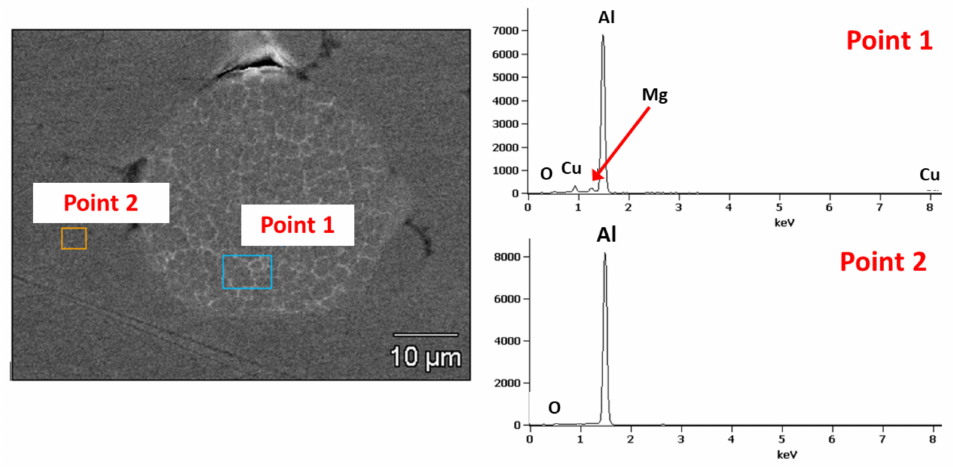
Figure 5. EDS analysis of contamination particles in Al